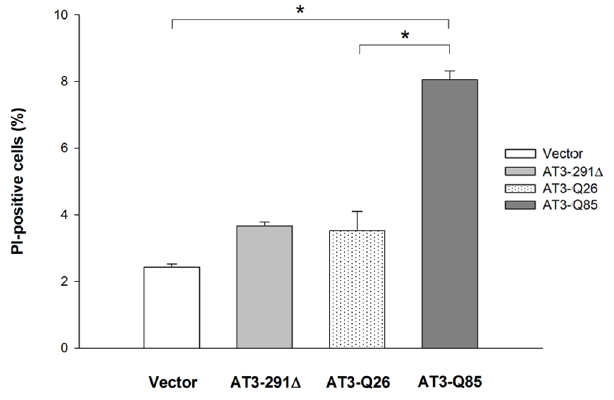
Fig 6. Propidium iodide staining of AT3-expression strains. After a 48-h induction, PI positive cells were counted from > 300 cells from different field views. Bars represent standard errors and are derived from at least three independent experiments (P <